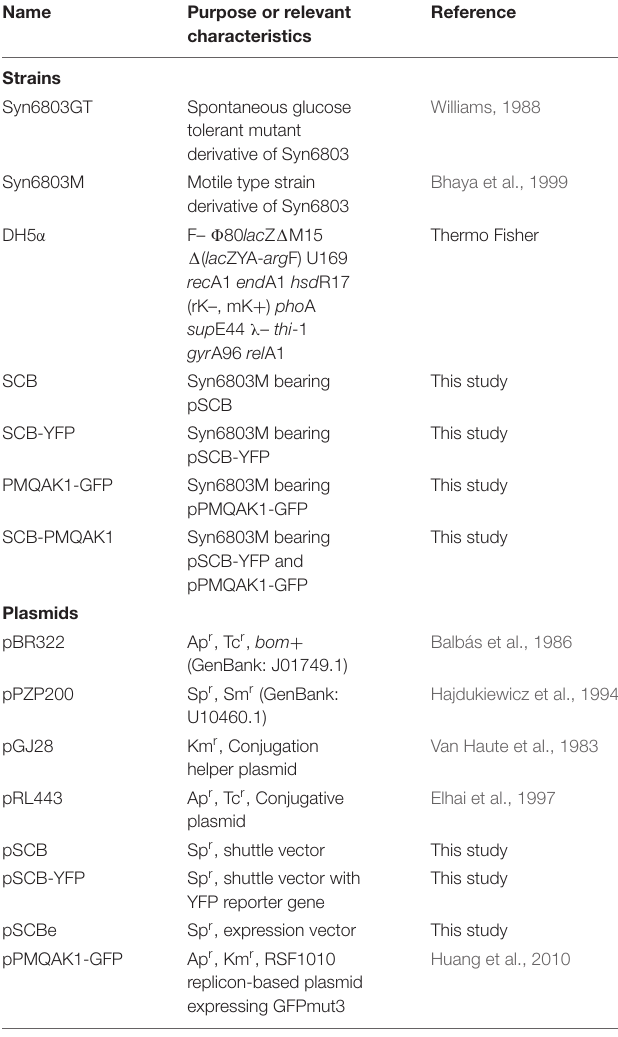
TABLE 1 | Strains and plasmids used in this